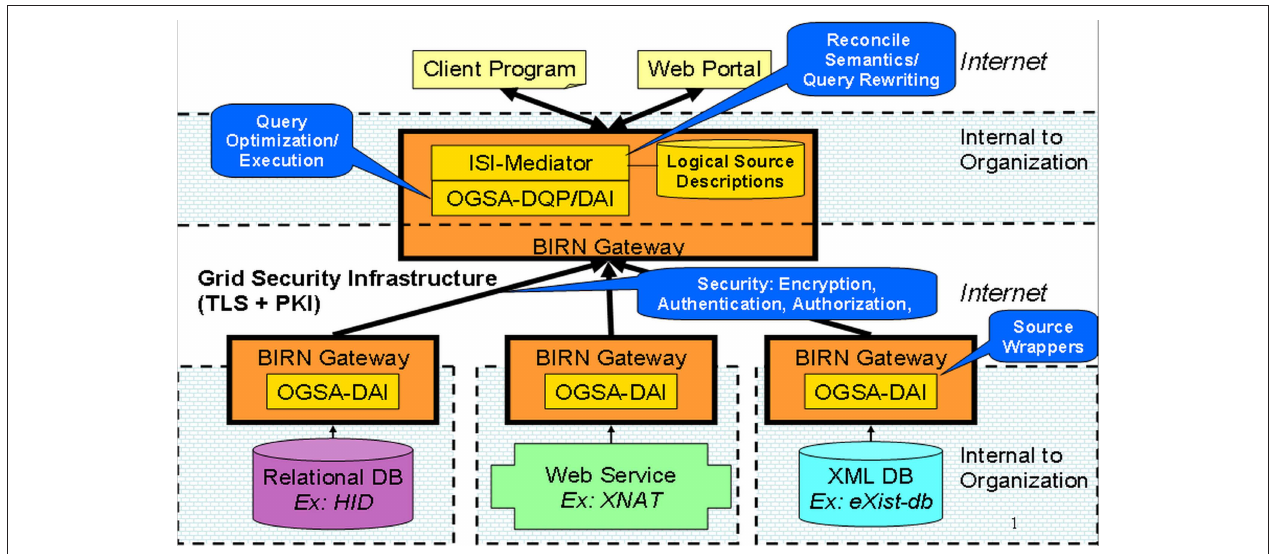
Figure 1 | Mediator